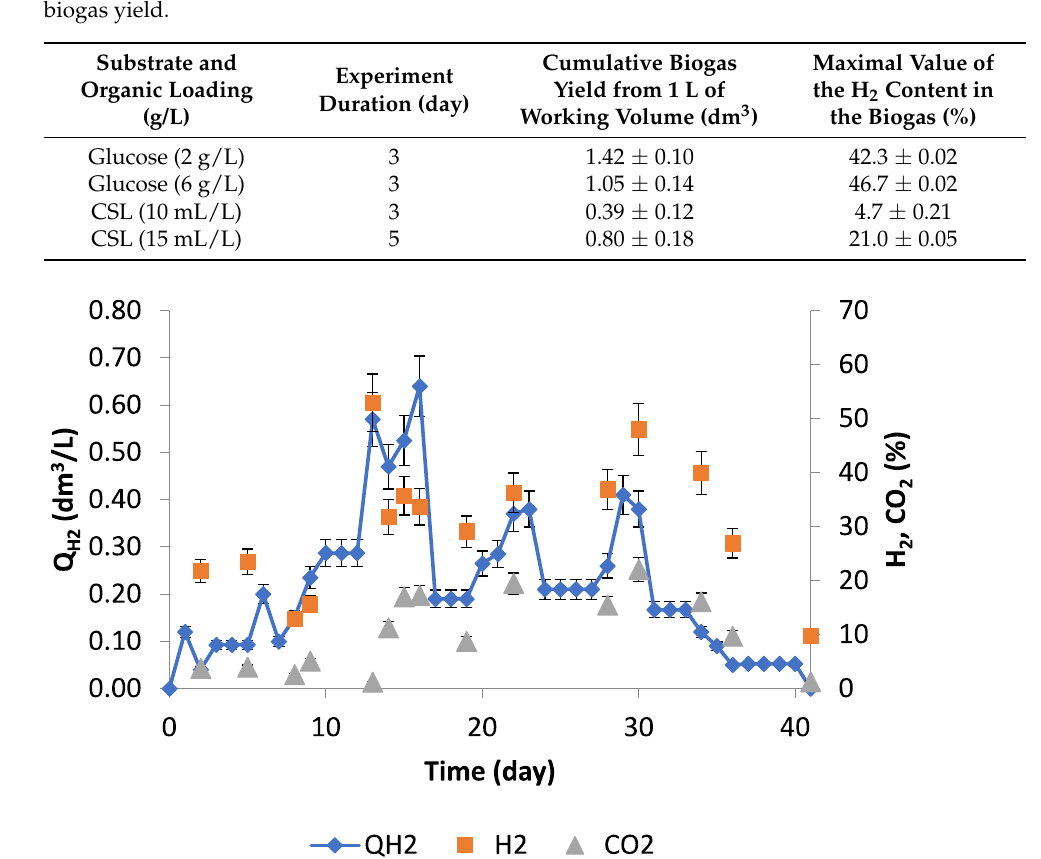
Figure 5. Daily biogas (biohydrogen) production (Q H biogas (%) from glucose in semi-continuous mode of